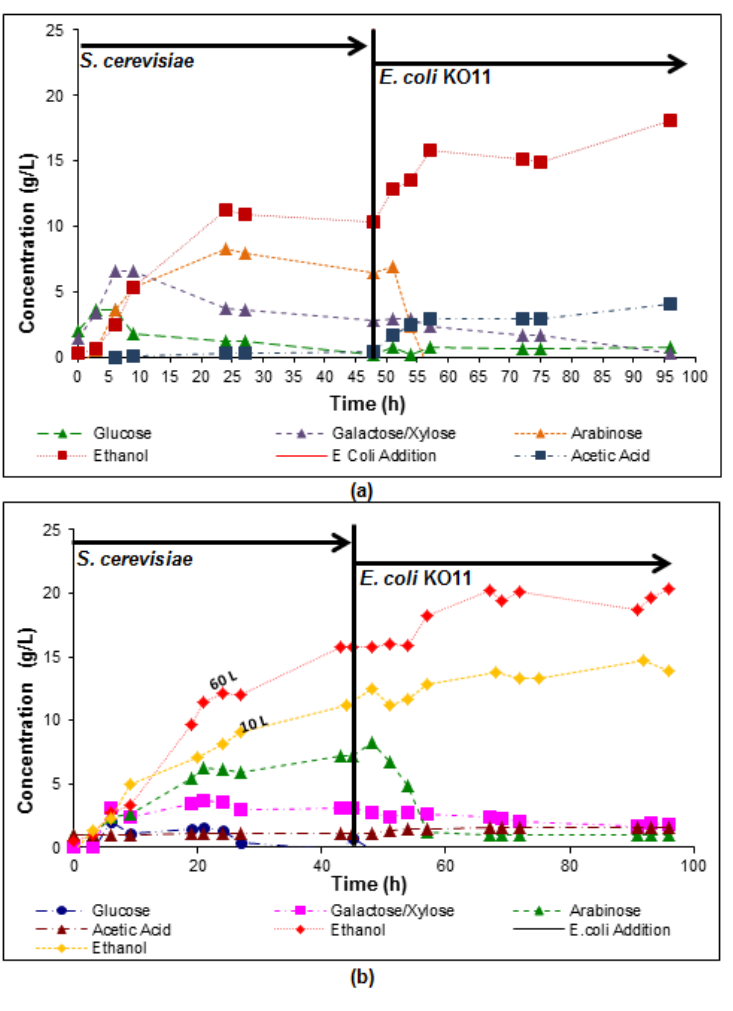
Figure 3. Evolution of the carbohydrate profile and ethanol concentration during ( a ) lab-scale (150 mL), and ( b ) pilot-scale (60 L) simultaneous saccharification and co-fermentation (SSCF) of IF with a 5% enzyme cocktail (for 10 L, only ethanol concentration is shown in ( b )). Fermentation 2018 , 4 , x 12 of 19